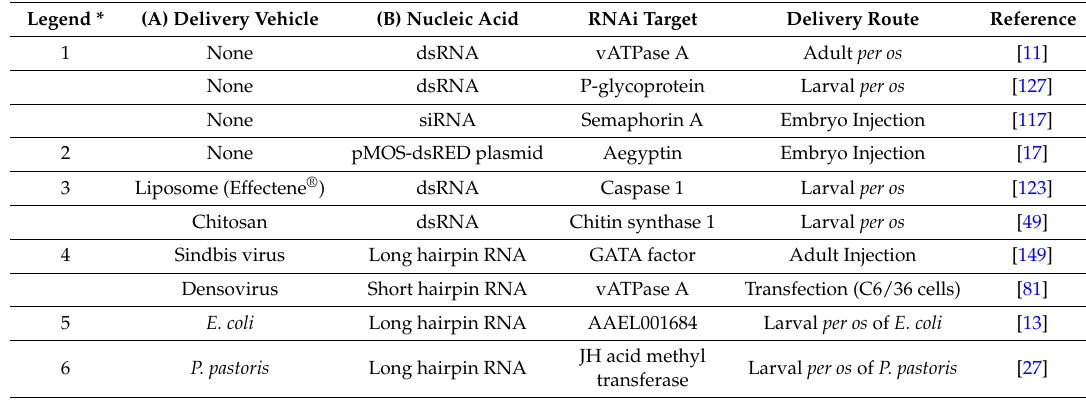
Table 2. Examples of RNAi trigger delivery systems (see also Figure